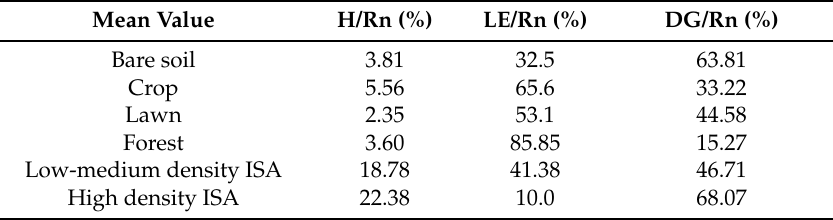
Table 3. Mean ratios of heat fluxes to net radiation over different LCTs.